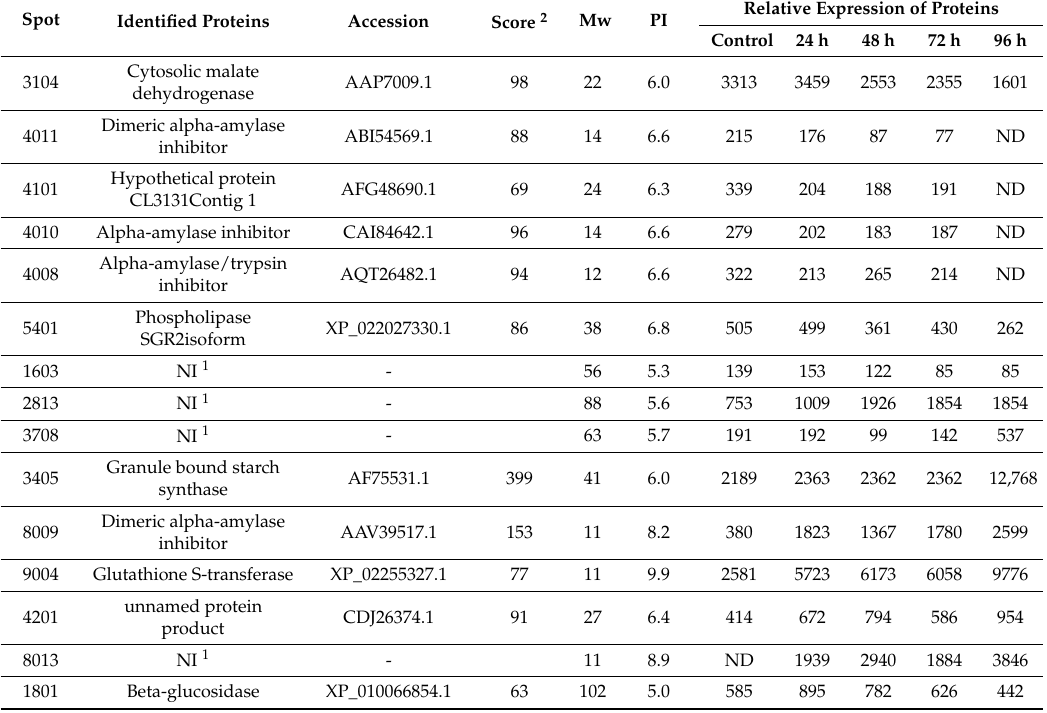
Table 2. Proteins detected on two-dimensional electrophoresis gels of ungerminated wheat grains and wheat grain samples germinated for various times (24, 48, 72, and 96